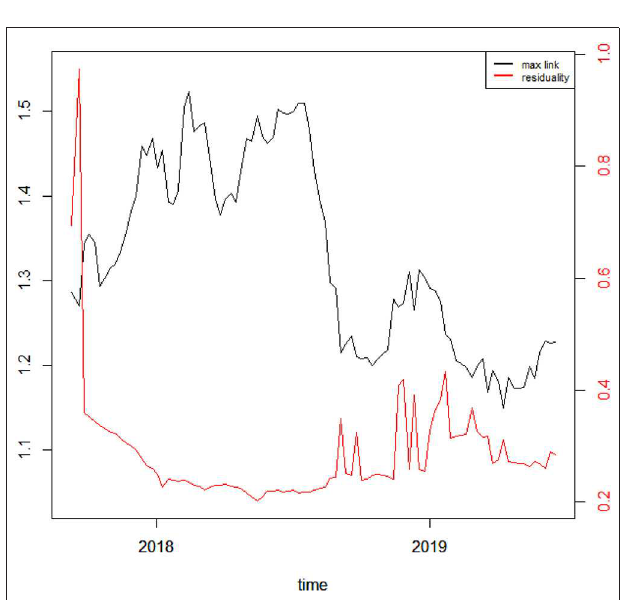
FIGURE 5 | MST thresholds and residuality coefficients. The black line shows the Max link distance, while the red line shows the residuality coefficient, whose values are reported, respectively on the left and right y axis.